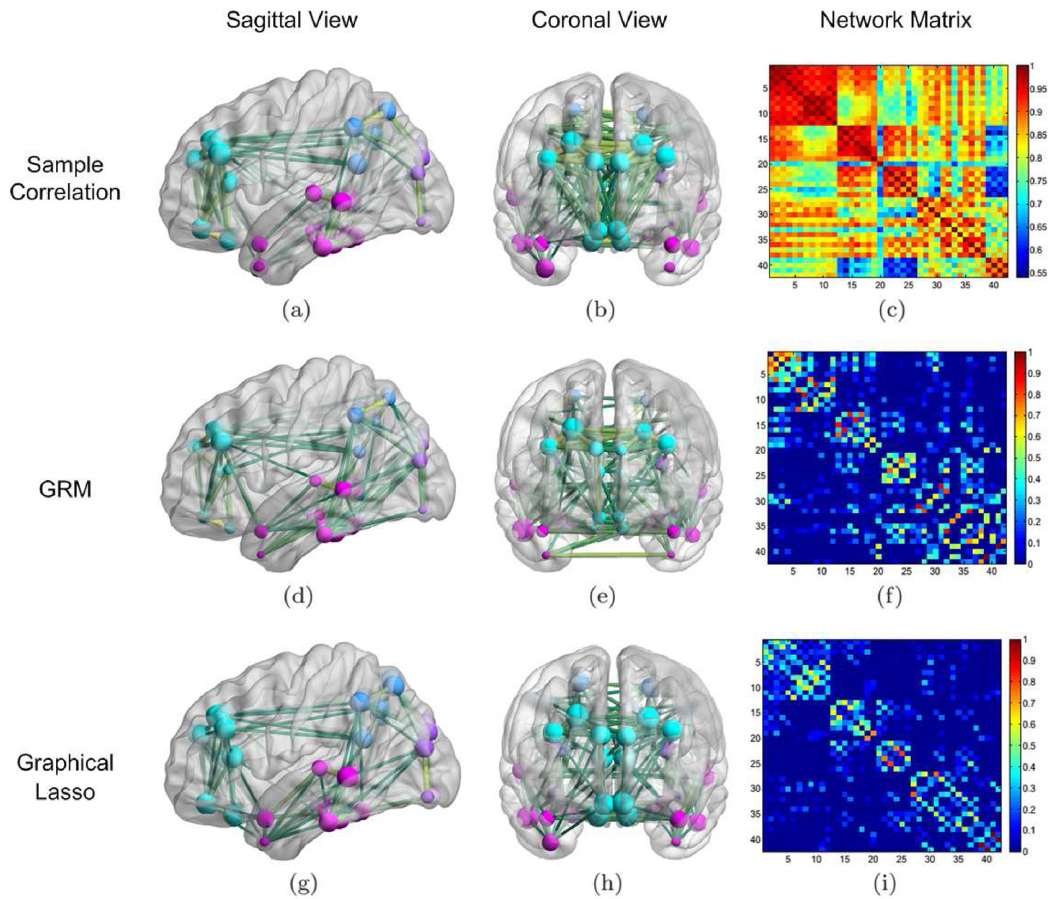
Fig 5. Network learning results of the NC group. Reconstruction results by the GRM from 40 NC subjects compared with those by sample correlation and graphical Lasso. For both GRM and graphical Lasso, results are obtained by keeping the same parameters as in the previous AD case. More detailed descriptions of the figure generation can be found in the caption of Fig